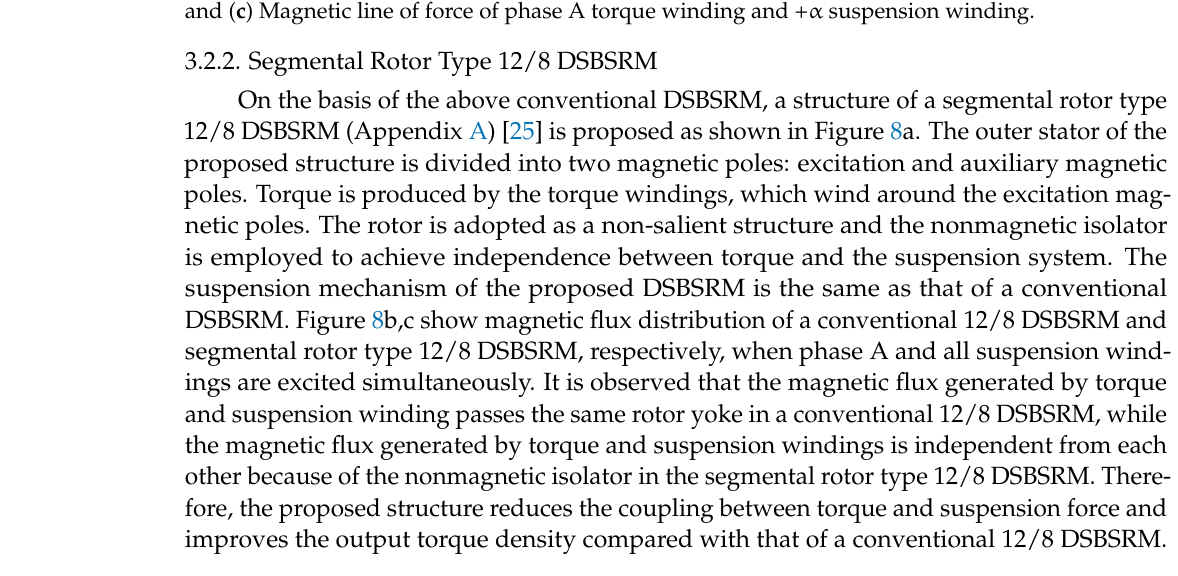
Figure 7. Double stator BSRM: ( a ) Phase A torque magnetic line of force; ( b ) +α and - β direction; and ( c ) Magnetic line of force of phase A torque winding and +α suspension winding.